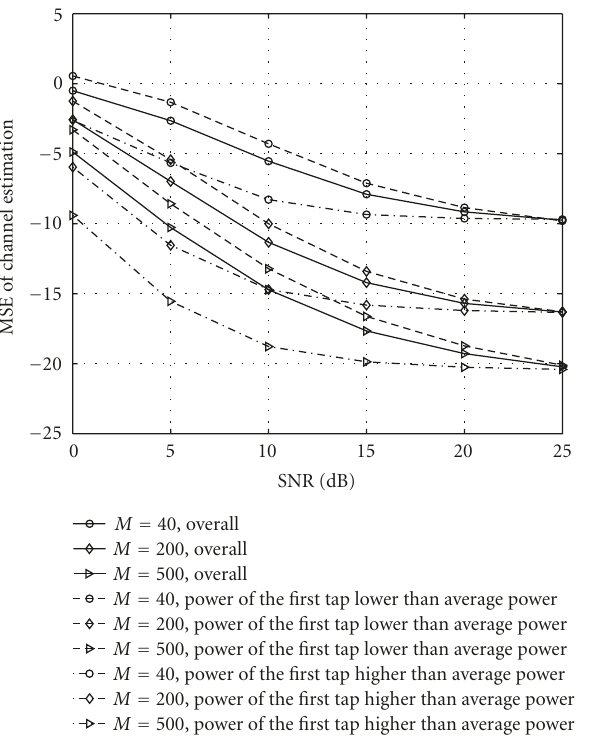
Figure 4: Performance sensitivity of the proposed channel estima- tion method to the relative power of the first